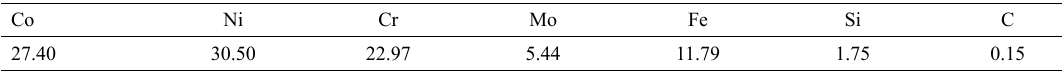
Figs. 2-4 are the SEM and EDS results of CoNiCrMo alloy after solution treatment at 1000°C, 1100°C and 1200°C. As can be seen from the graph, the deeper color of the dendrites branches indicates that they are corroded, while the lighter color of the parts between the dendrites branches indicates that Table 1. The Chemical composition of CoNiCrMo alloy